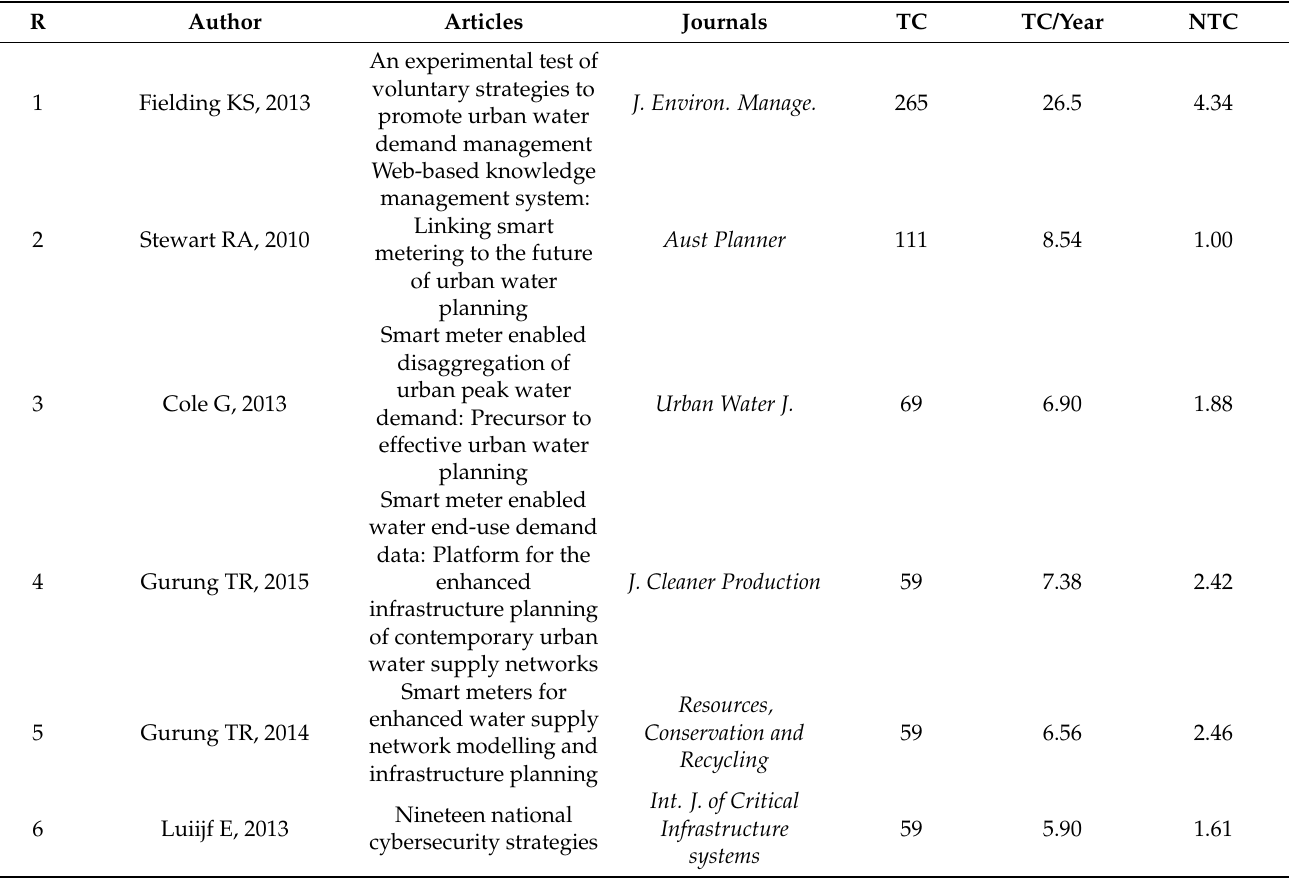
Table 4. Top 15 most global cited documents in Australia (R = rank; TC = total citations; NTC = normalized total citations).